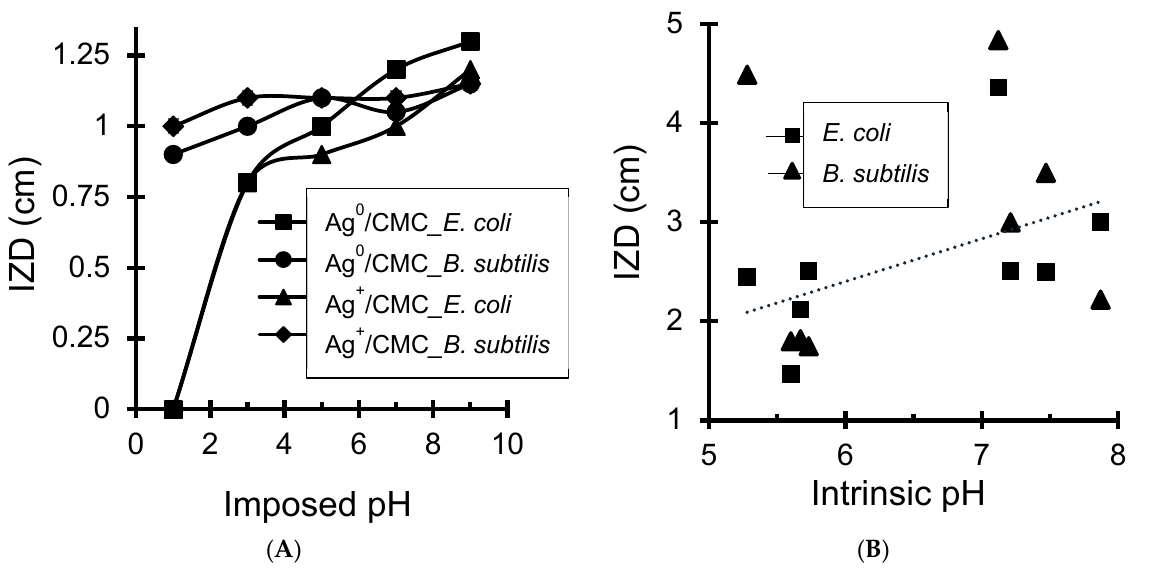
Figure 7. IZD dependence on imposed initial pH ( A ) and intrinsic pH of metal-loaded biopolymers ( B ).